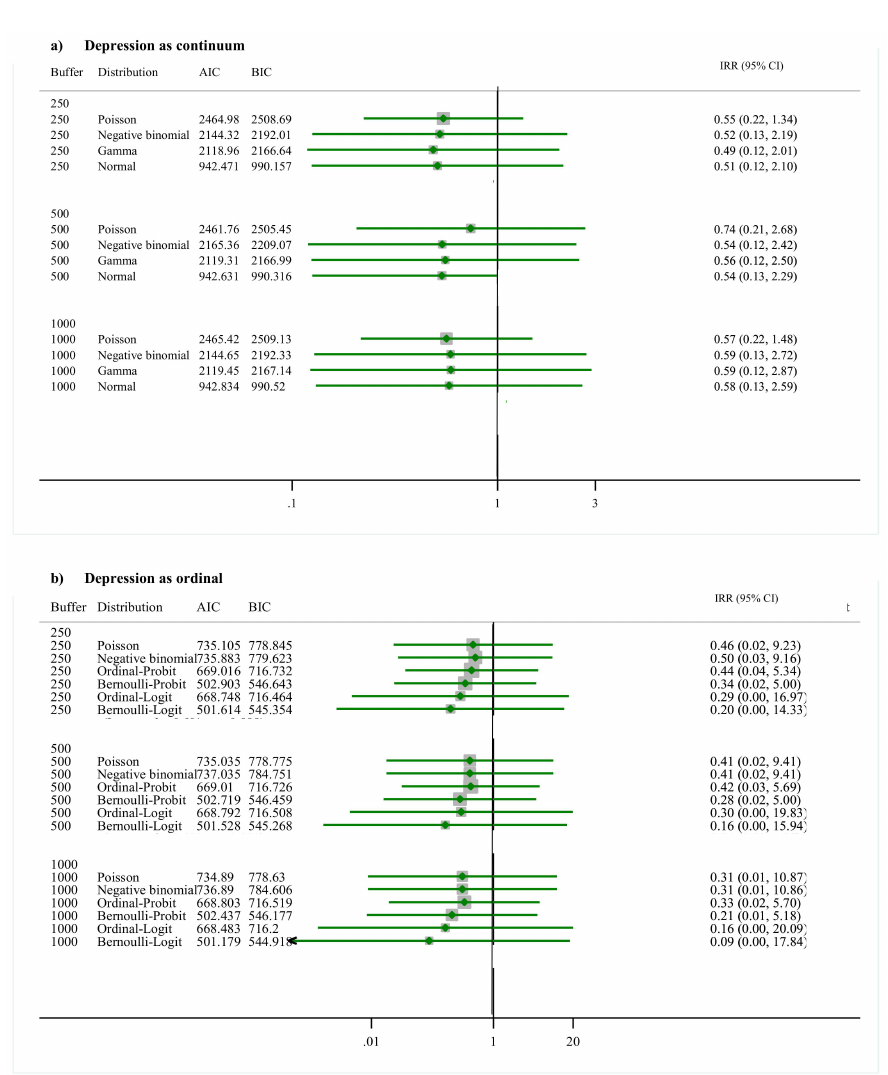
Figure 1. Direct association between depression ( a ) continuum and ( b ) ordinal variable and greenness summarized at bu ff er sizes of 250 m, 500 m, and 1000 m. Note : Bu ff er indicates distances in